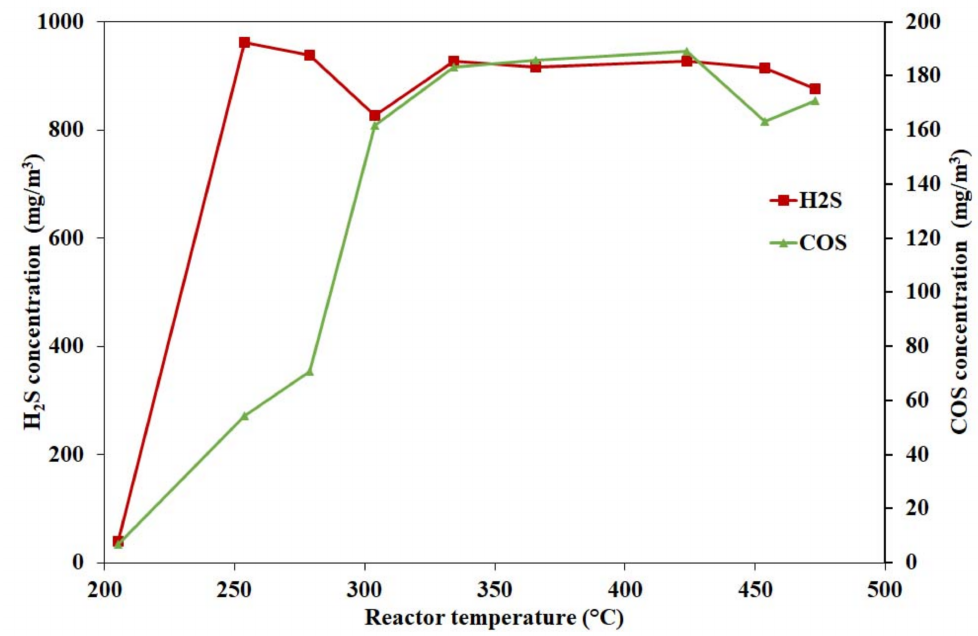
Figure 23. Catalytic tests with feed gas mixture 3 (50 mole% CO, 34 mole% H 2 , 8 mole% CO 2 , 0.4 mole% H 2 S, balance N 2 ) at pressure 0.5 MPa over a Co-based catalyst (9.6 wt%). Content of H 2 S and COS in the gas